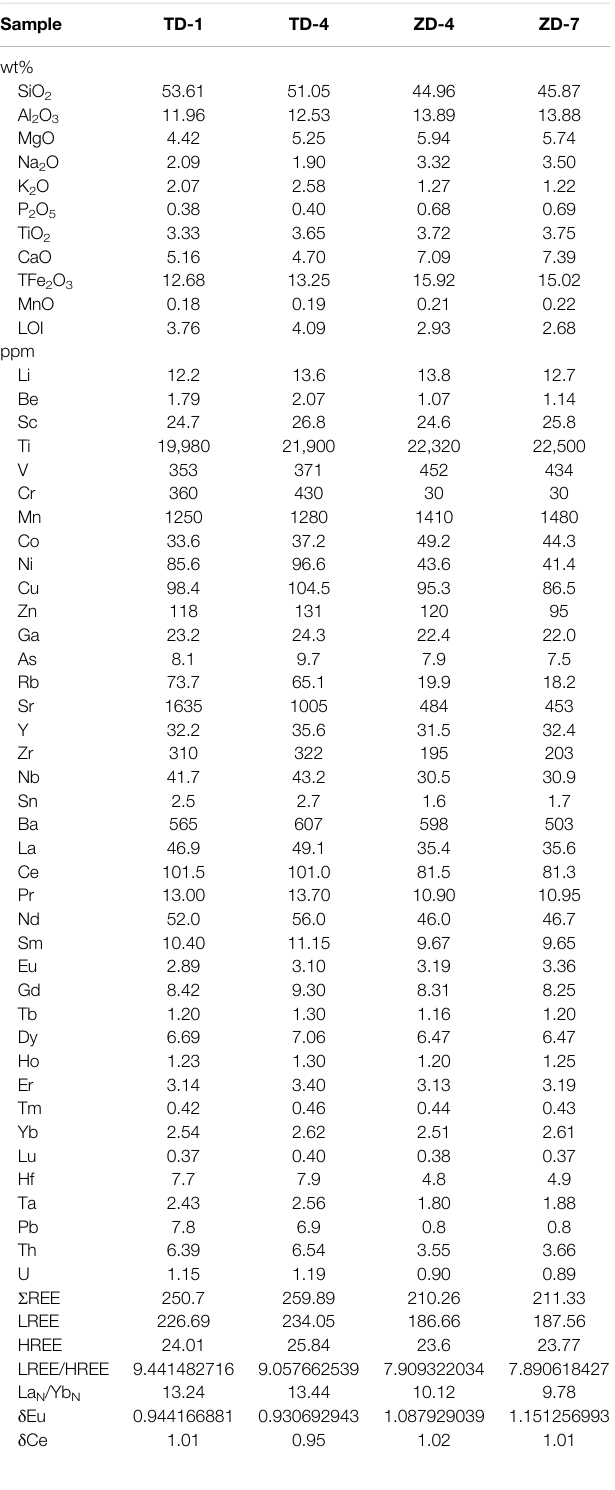
TABLE 1 | Major element (wt%) and trace element (ppm) compositions for the Longlin basalt samples.